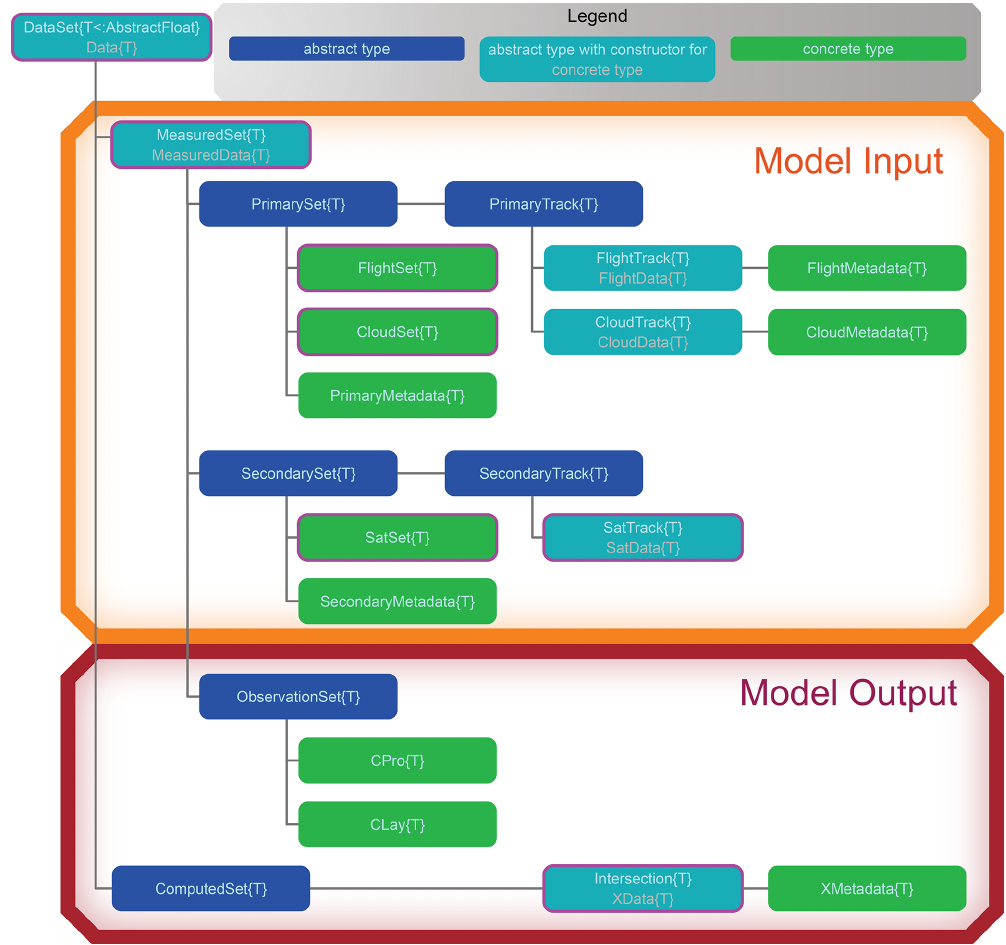
Figure 1. Type tree used in the TrackMatcher